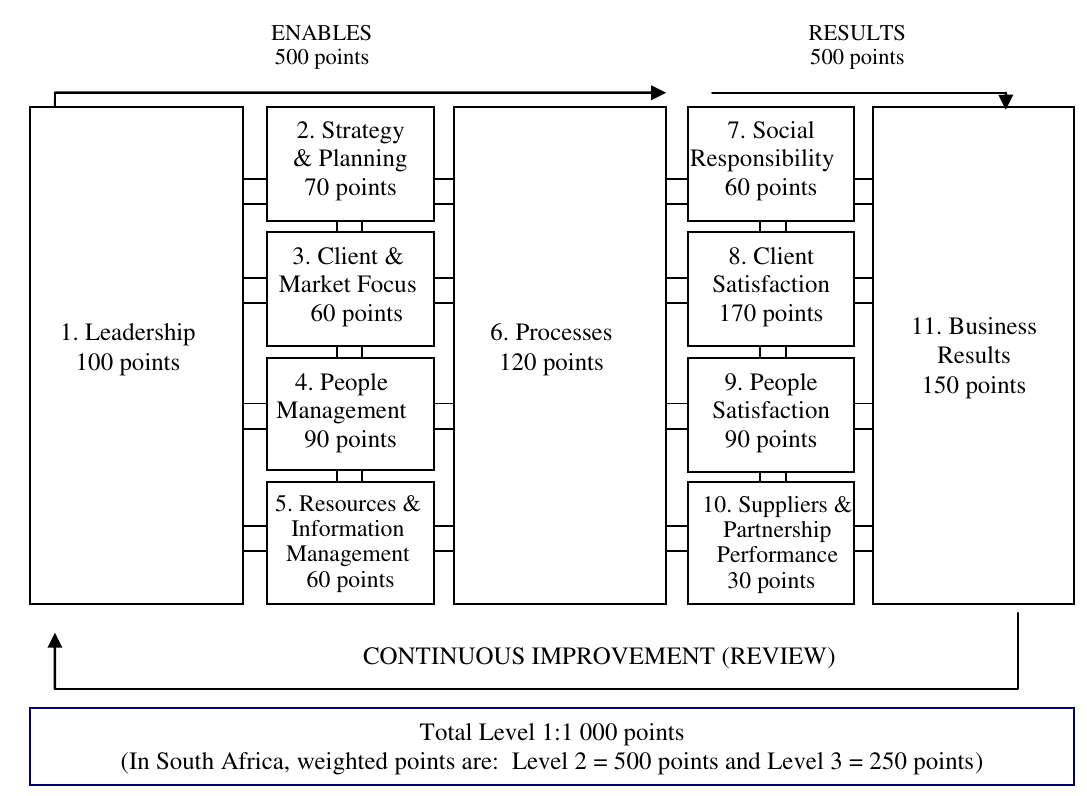
Fig. 1. South African Excellence Model